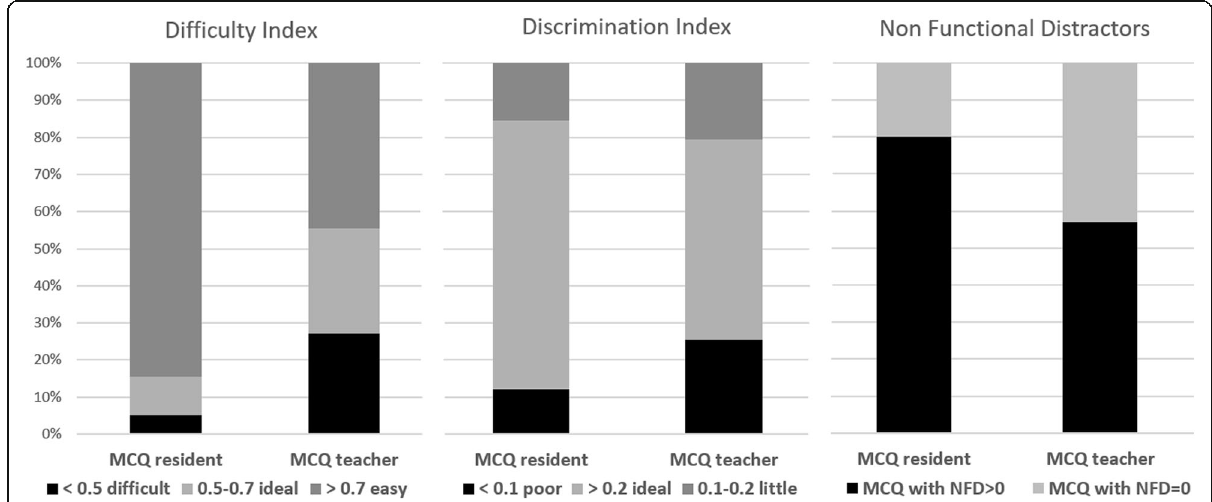
Fig. 2 Proportion of degrees of difficulty and of discriminating power and number of NFD in MCQ resident and in MCQ